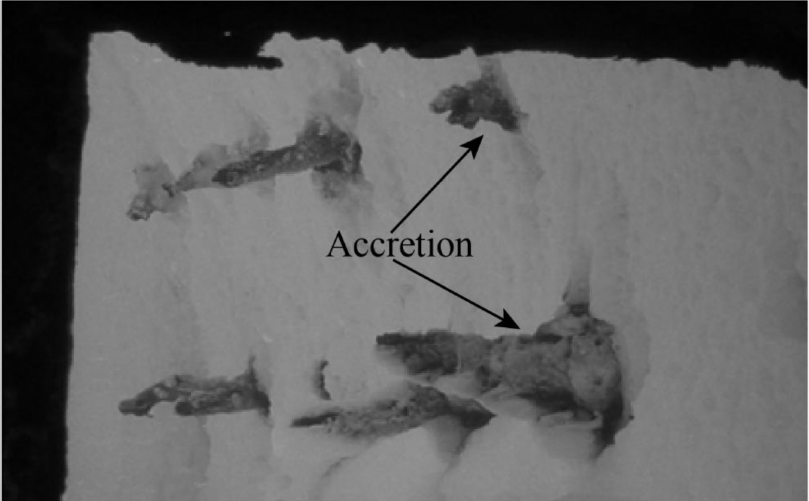
Figure 3. “Mushroom” tips formed on the lances of the Fangyuan BBF. Reprinted with permission from ref. [7]. Copyright 2021 John Wiley and